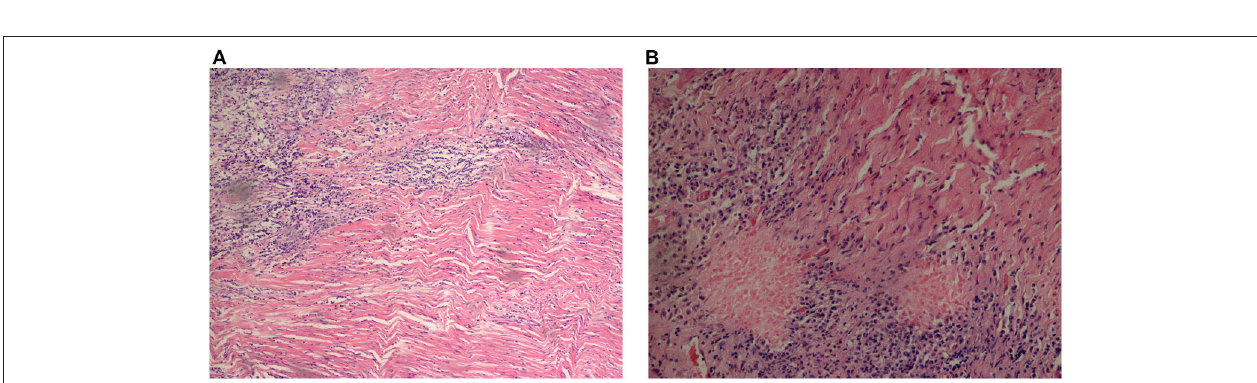
FIGURE 4 | Pathological results of dura mater from an idiopathic HP patient. T cell and B cell infiltration were shown by immunohistochemistry. (A) (Right dura mater and underneath) fibrosis and regional hyaline, with chronic inflammatory cell infiltration, 200 × . (B) 400 ×